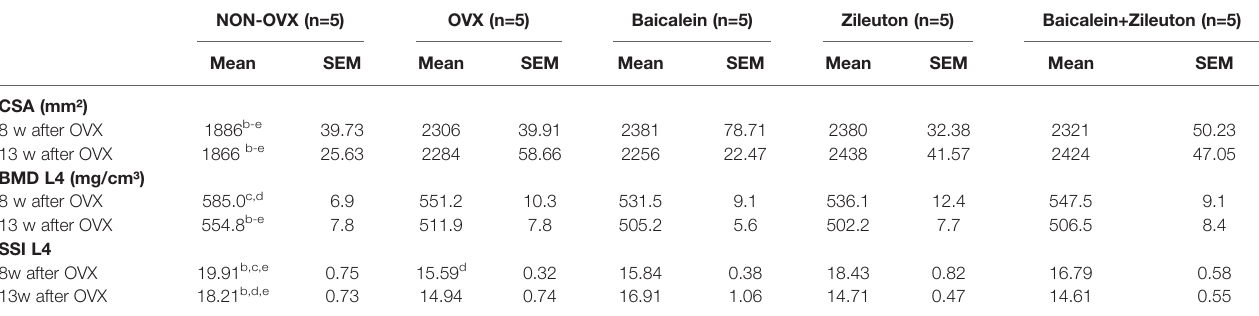
TABLE 2 | L4, in vivo pQCT.